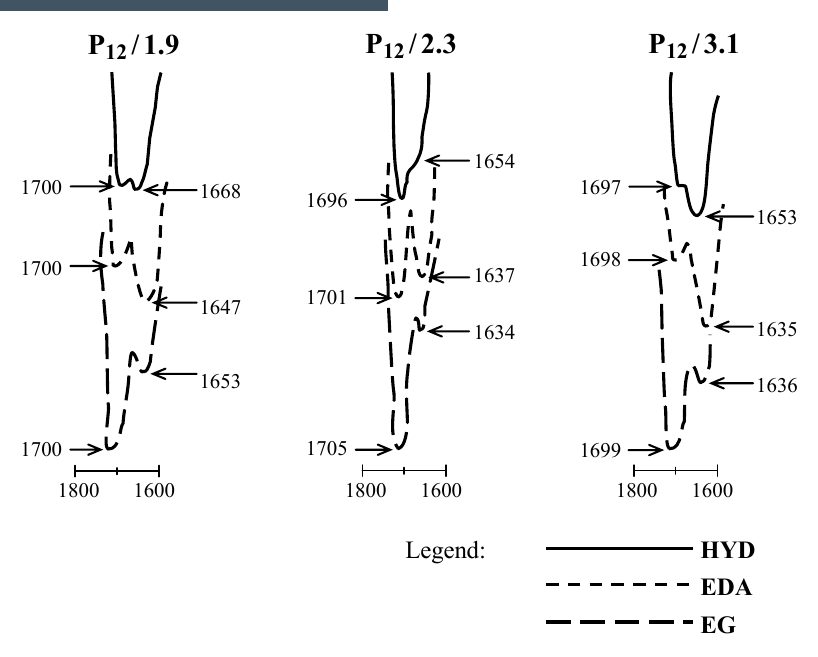
Figure 3. Profile of the absorption bands and the respective frequency values in cm − 1 corresponding to carbonyl groups of cast films from wPUU, chain-extended with hydrazine (HYD) and ethylenediamine (EDA), and wPU, chain-extended with ethylene glycol (EG), synthesized using the mixture of polyols (P 12 ) and variation in the rigid segments content (NCO/OH = 1.9, 2.3 and